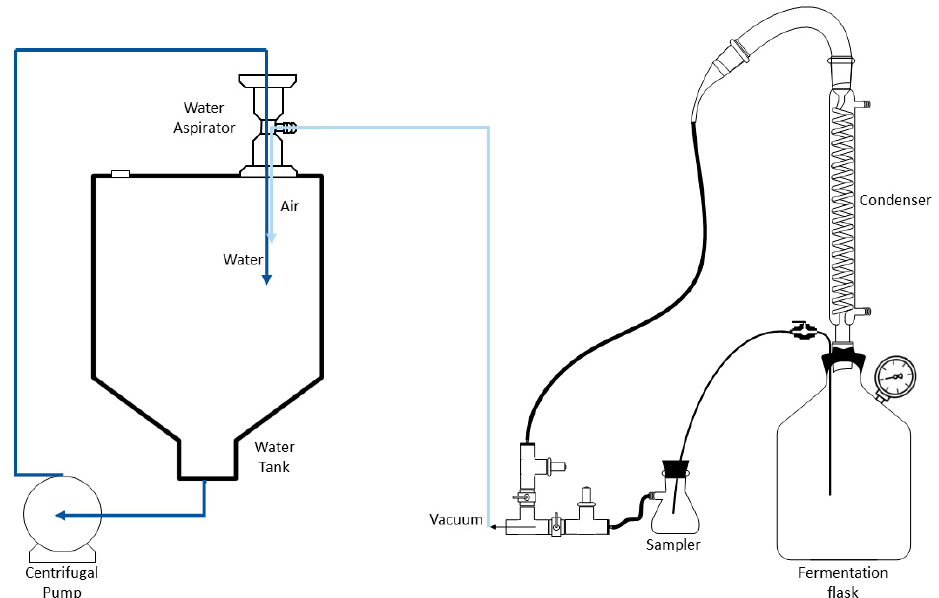
Figure 1. Diagram of equipment used during fermentation experiments. Water aspirator was at- tached to the fermentation vessel (flask) during low pressure fermentation and was maintained at 24.1